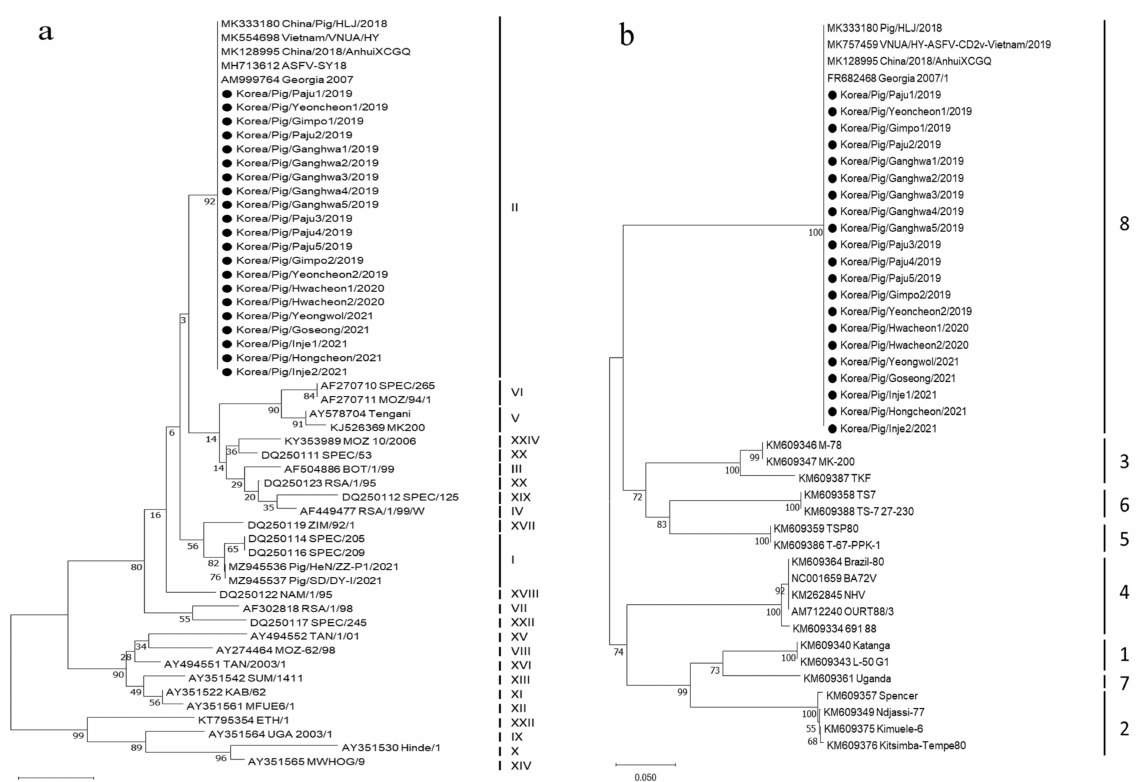
Figure 3. Phylogenetic trees of the 21 ASFV strains isolated from domestic pig farms in 2019–2021, constructed based on partial sequencing of the B646L and EP402R genes. ( a ) p72 genotype and ( b ) EP402R serogroup. The neighbor–joint method and Kimura 2-parameter model were used to construct both phylogenetic trees in MEGA X software (https://www.megasoftware.net/ (accessed on 15 November 2020)). Black dots indicate the Korean ASFV